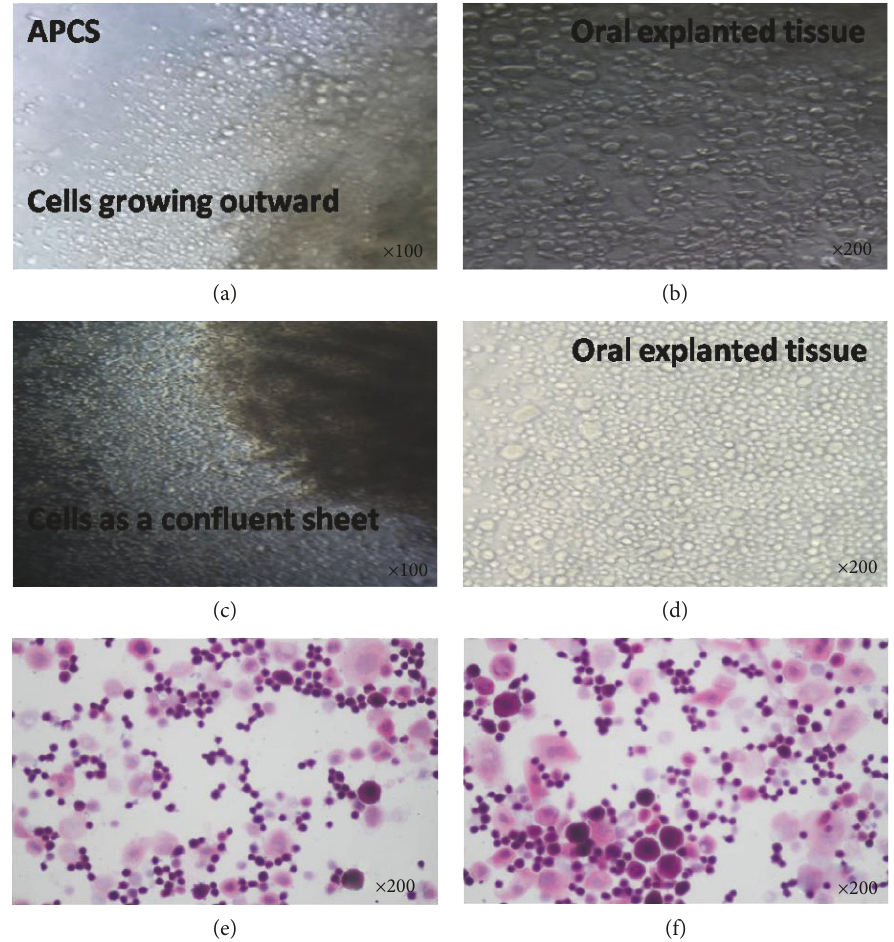
Figure 2: (a), (b) Morphologic fi nding of OME cells growing on APCS for 2-3 days. Magni fi cation: (a) × 100; (b) × 200. (c), (d) OME cells as a con fl uent sheet on APCS (after 1-2 weeks). Magni fi cation: (c) × 100; (d) × 200. (e) OMEC (on APCS) (after 2 weeks) stained with H&E (magni fi cation, × 200). (f) OMEC (on HAM) (after 2 weeks); stained with H&E (magni fi cation, × 200).